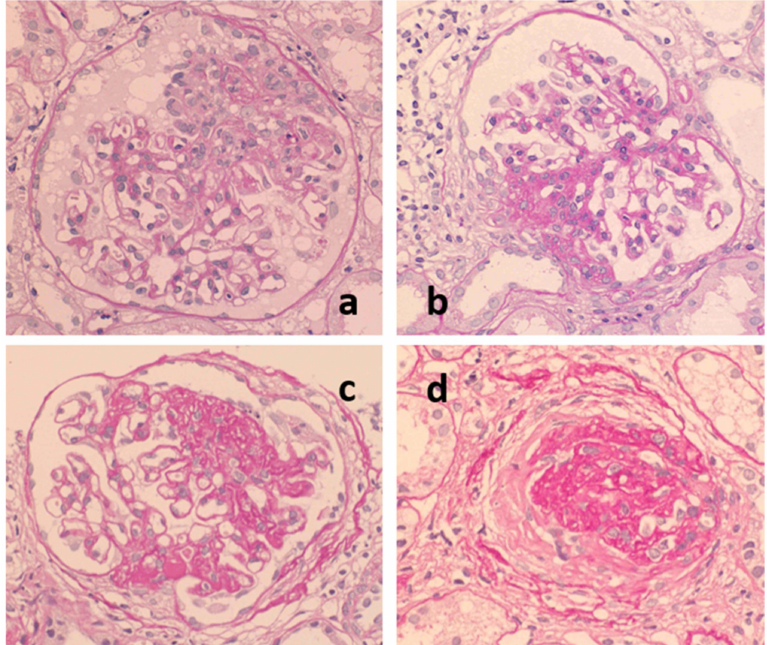
Figure 2. The glomerular sclerosing process following glomerular vasculitis. Following glomerular vasculitis ( a ), segmental glomerular sclerosis develops as a healing scar lesion ( b ). The accumu- lation and expansion of segmental glomerular sclerosis lesions ( c ) ultimately lead to glomerular obsolescence ( d ). PAS, original magnification ×